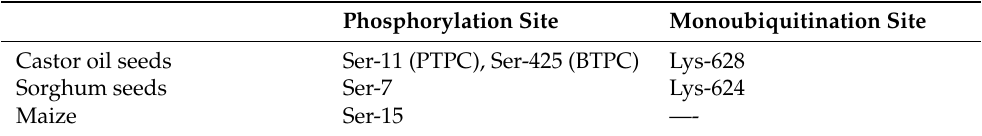
Table 3. List of phosphorylation and monoubiquitination sites of several known plants. Phosphorylation Site Monoubiquitination Site Castor oil seeds Ser-11 (PTPC), Ser-425 (BTPC) Lys-628 Sorghum seeds Ser-7 Lys-624 Maize Ser-15